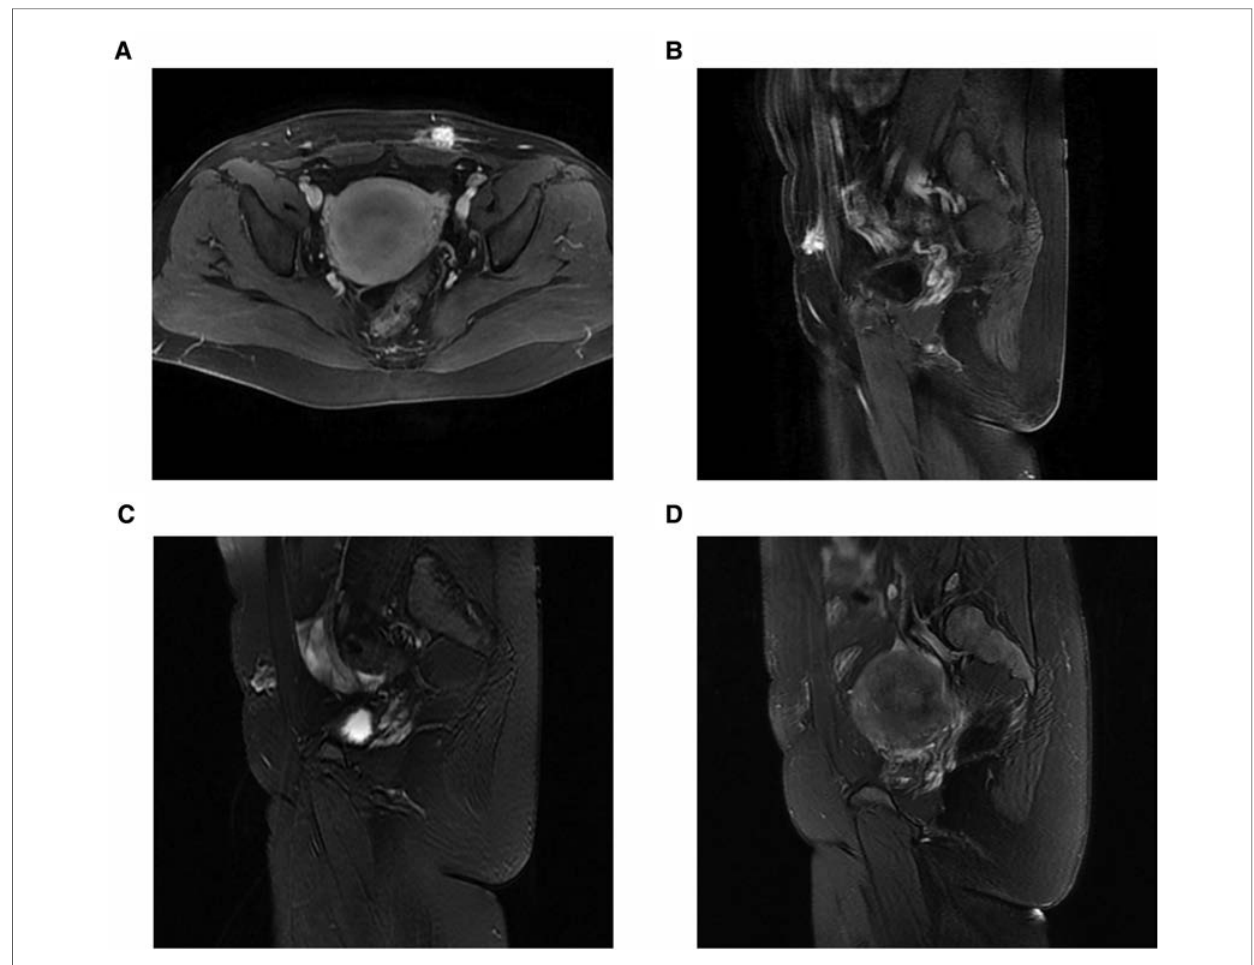
FIGURE 5 MRI of a 31-year-old patient with abdominal wall endometriosis treated with ultrasound-guided microwave ablation. Before microwave ablation, MRI showed remarkable enhancement on enhanced fat-suppressed T1-weighted axial images ( A ) and sagittal images ( B ), and inhomogeneous high-signal intensity on the T2-weighted sagittal images ( C ). After treatment, coagulation necrosis in the lesion area indicated that there was no residual enhancement at the treatment site and that the lesion had decreased in size ( D ). MRI, magnetic resonance